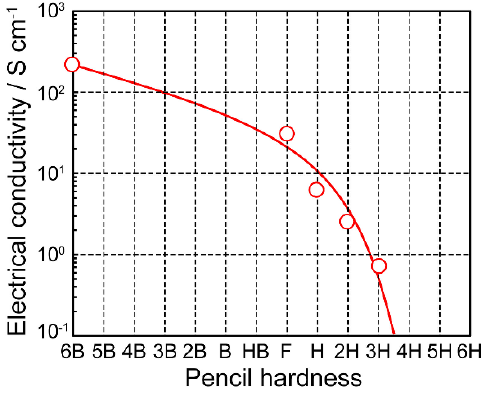
Figure 19. Correlation between pencil hardness and electrical conductivity of trGO/SiO 2 films.